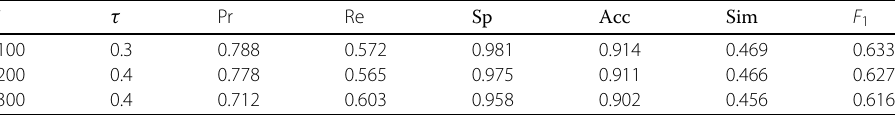
Table 6 Best evaluation results for each i for MGAC i τ Pr